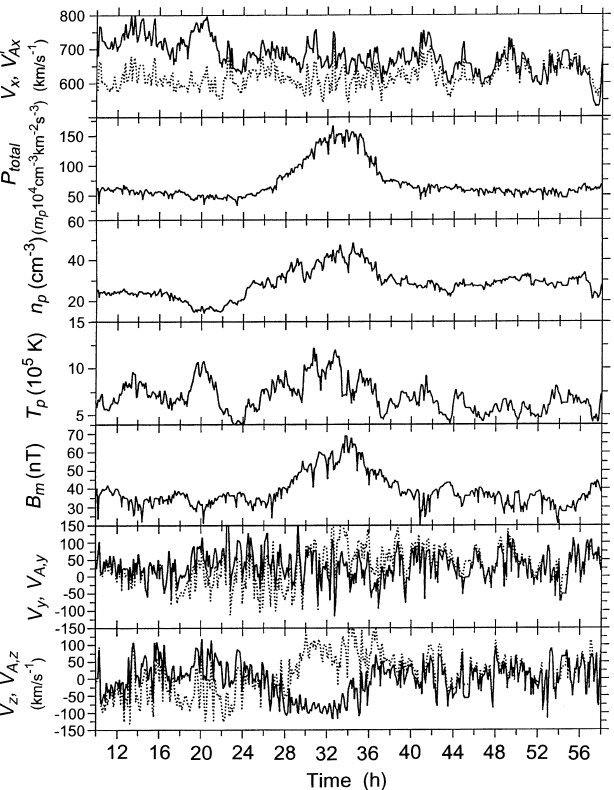
Fig. 1. Time-sequence of solar-wind parameters as observed by Helios 2 from day 110, hour 10, to day 112, hour 10, in 1976. From the top panel to the bottom panel we have: the radial components of the flow velocity ( solid line ) and Alfve´n velocity (plus 750 km Æ s ) 1 , V ¢ A ) indicated by a dotted line ; the total pressure (electron temperature is assumed to be equal to the proton temperature) in units of m p 10 4 cm ) 3 km 2 Æ s ) 2 ; the proton number density; the proton temperature; the magnetic-field magnitude; the y and z ( bottom panel ) components of the solar-wind bulk velocity and of the Alfve´n velocity. The data were averaged over 405 s, corresponding to ten plasma instrument measurement cycles. Note the